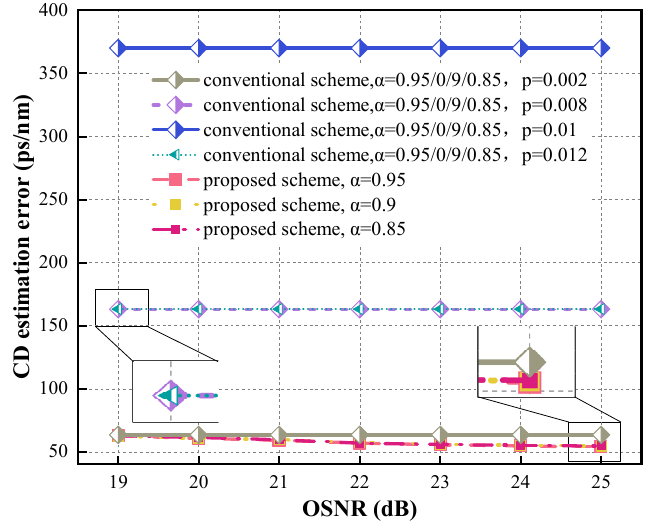
Figure 6. The mean value of the absolute CDE error vs. different OSNRs.